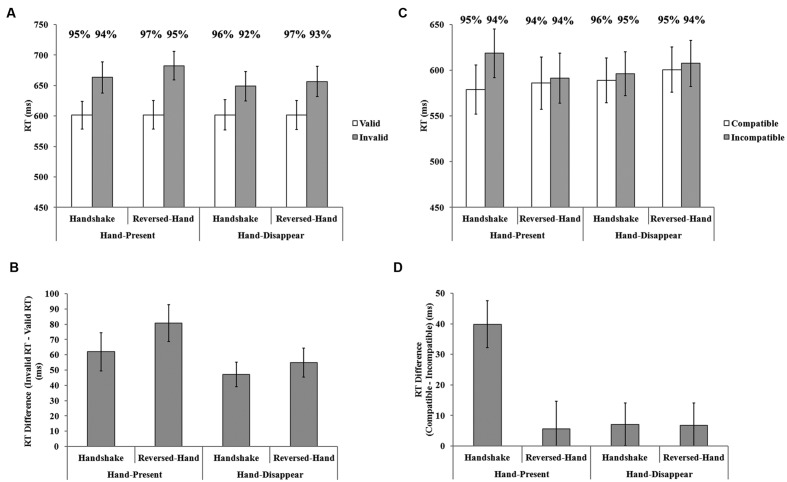
Results of Experiment 3. (A) and (B) respectively, depict the mean RT and RT difference between the invalid and valid trials for the cueing task. (C) and (D) respectively, depict the mean RT and RT difference between the compatible and incompatible trials for the interference task. Error bars indicate standard errors. Mean accuracy rates for every condition was shown above the corresponding bars.